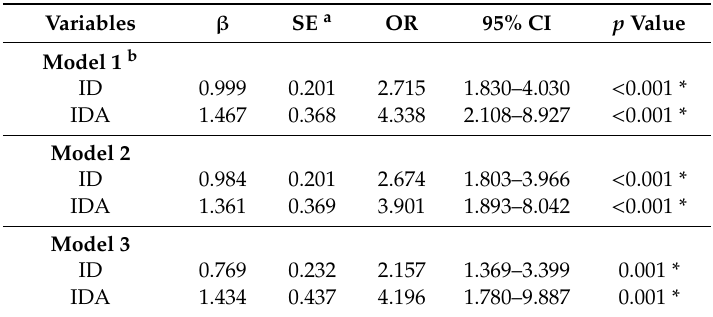
Table 4. Association between feeding type and iron status.